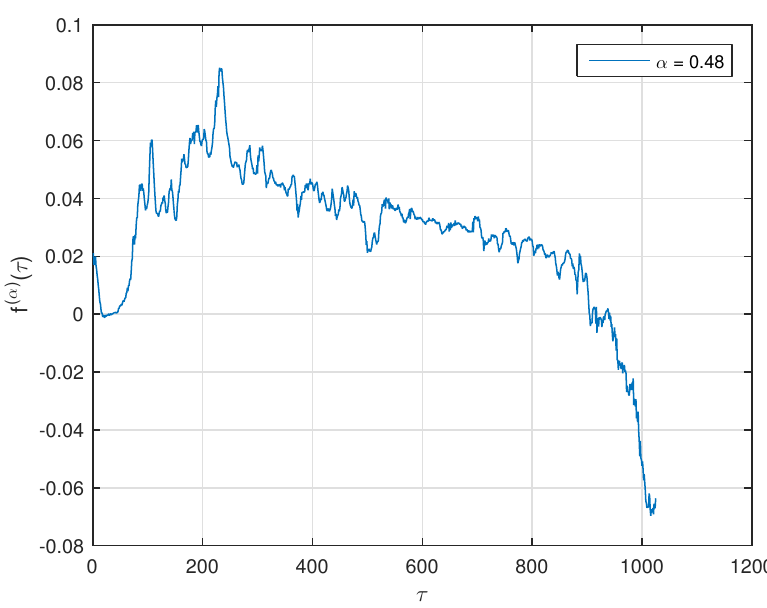
Figure 5. The change of CO and CO 2 concentration for order α =